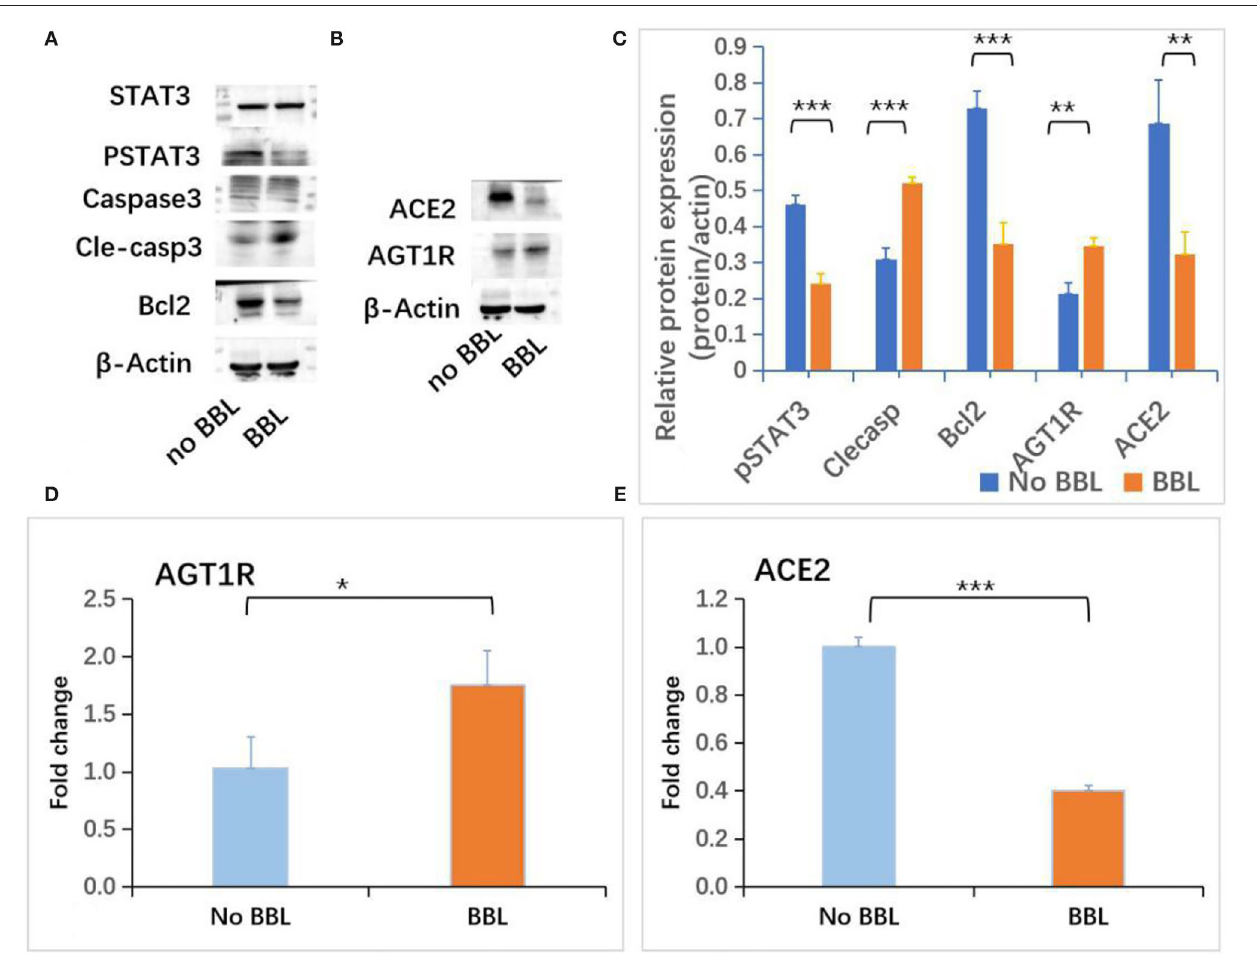
FIGURE 5 | Increased expressions of pSTAT3 and ACE2 were associated with BBL SIAKI. (A) Western blot analyses of STAT3, pSTAT3, caspase 3, cleaved-caspase 3 and Bcl-2 levels in renal cortex tissues of CLP AKI mice. (B) Western blot analyses of ACE2 and AGT1R levels in renal cortex tissues of CLP AKI mice. (C) The differences of pSTAT3, Cleaved-caspase 3, Bcl2, AGT1R and ACE2 expressions between No BBL and BBL mice. (D) The difference of AGT1R mRNA expression determined by RT-PCT between No BBL and BBL mice. (E) The difference of ACE2 mRNA expression determined by RT-PCT between No BBL and BBL mice. *, p < 0.05; **, p < 0.01; ***, p <